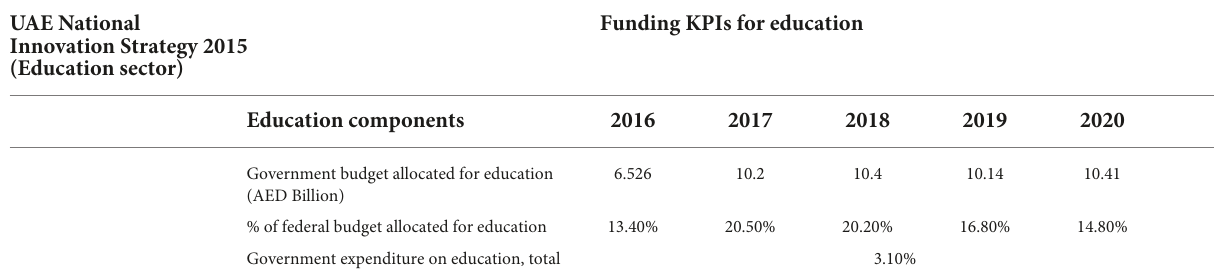
TABLE 3 Innovation capabilities inter relation with human development index (HDI) key performance indicators (KPIs) of education (2014–2020). Innovation